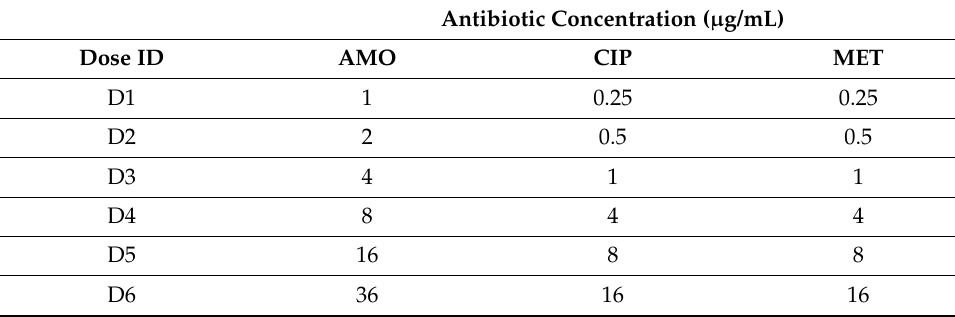
Table 1. Concentrations of the antibiotics used in the